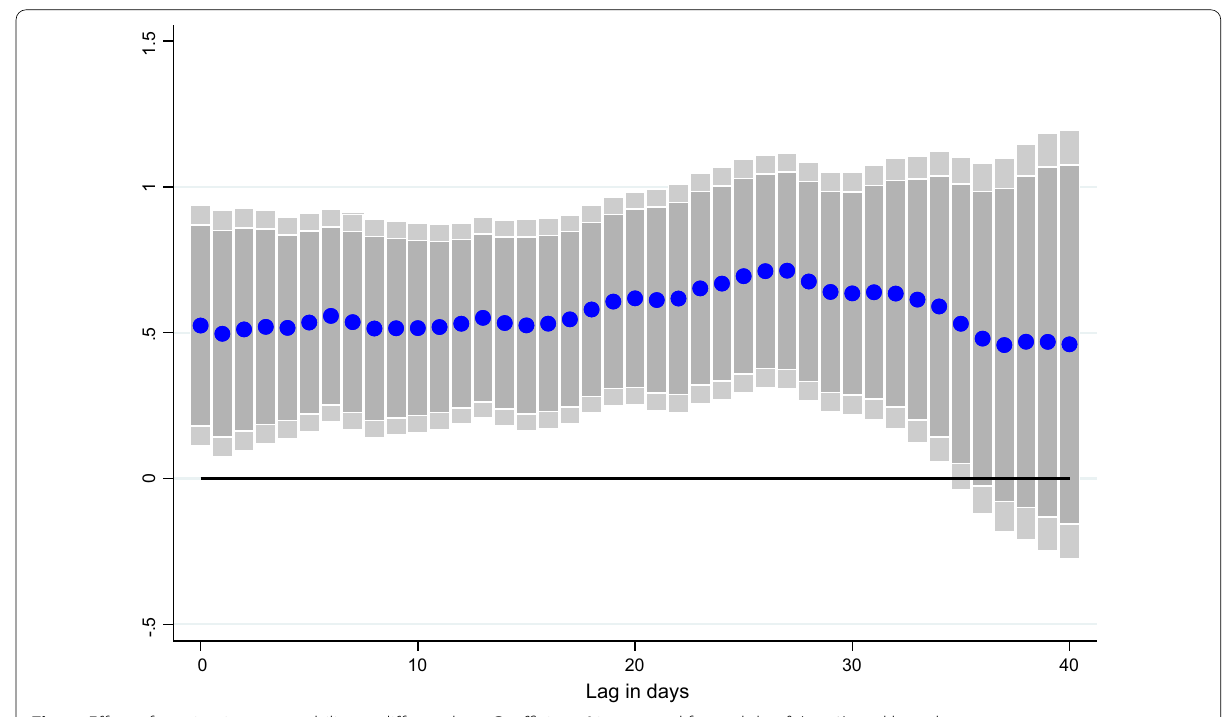
Fig. 5 Effect of vaccinations on mobility, at different lags. Coefficient β is reported for each lag ℓ (1–40), and based on � Y i , t = α + µ i + γ t + β SV i , t − l + θ X i , t − l + ε i , t for a sample of 44 countries using daily data from December 20, 2020–June 16, 2021. Y i , t denotes changes in retail and recreation mobility and SV i , t − l is the surprises in vaccines administered (per capita). µ i and γ t are the country and time fixed effects. X is a vector of control variables which includes the level of new cases, NO 2 and CO emissions per capita, the stringency of containment measures index, and mobility indices at t-1 . Lightly shaded bars denote 90 percent confidence bands, and dark-shared bars denote 95 percent confidence